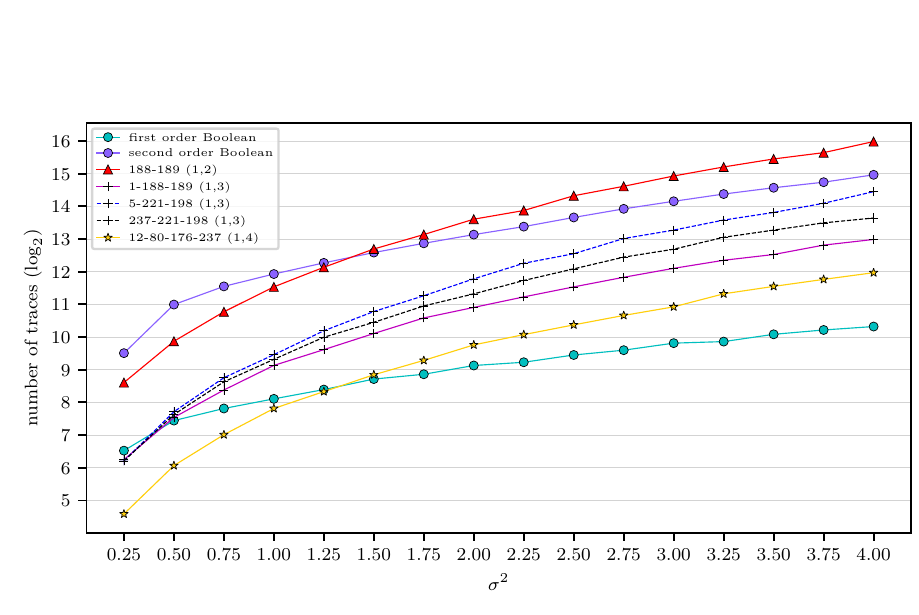
Figure 4: Attacks on (1 , n ) with sets of interpolation points stable under the Frobenius automorphism for 0 . 25 ≤ σ 2 ≤ 4 . 0 and comparison with Boolean masking and “normal” sets of interpolation